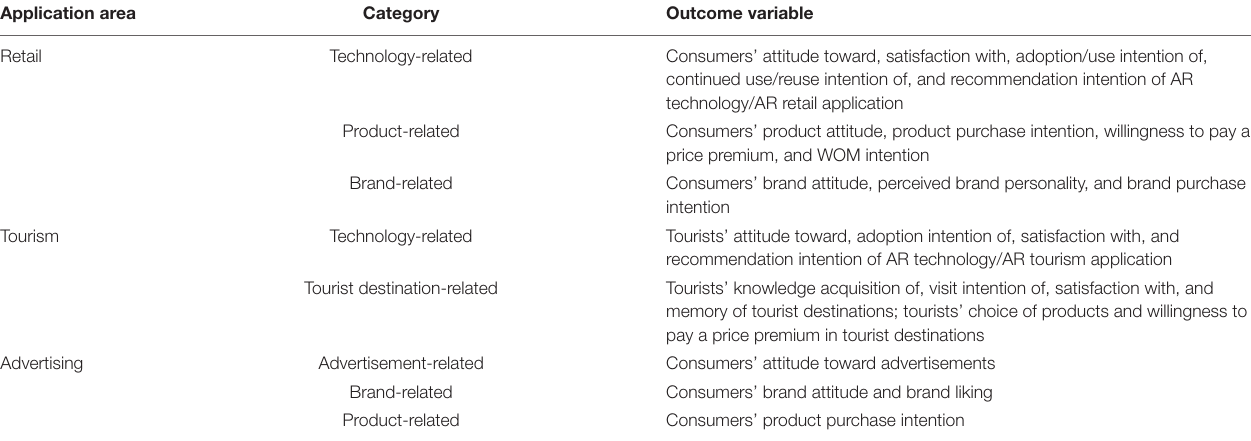
TABLE 4 | Outcome variable.